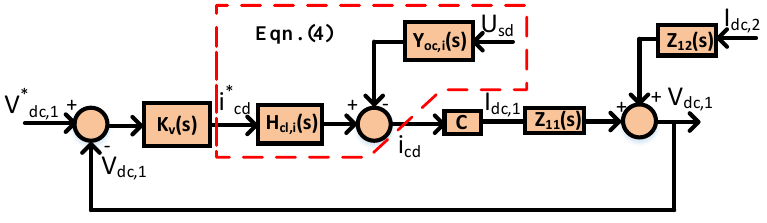
Figure 7. Control block diagram of the DC voltage